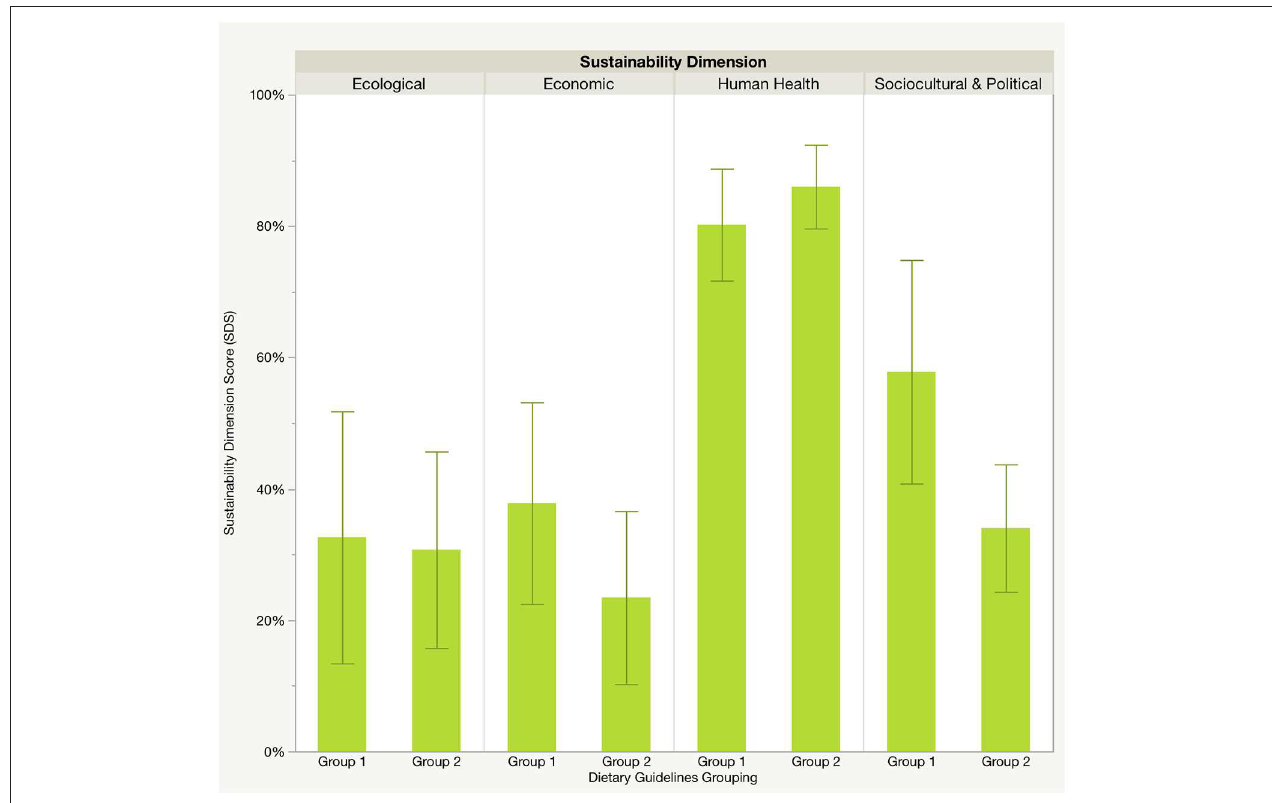
FIGURE 1 | Variation of sustainability dimension scores (SDS) between ecological, economic, human health, and socio-cultural and political sustainability in national dietary guidelines. Application of the sustainability framework tool ( Table 1 ) for presence of sustainability dimensions found sustainability dimension scores (SDS) varied between the four sustainability dimensions with human health being the most represented dimension in the national dietary guidelines examined. Overall, results indicate that the ecological, economic, and socio-cultural and political dimensions of sustainability are underrepresented in national dietary guidelines. Significant differences ( p < 0.0001) were found in means SDS between the four sustainability dimensions. Pair-wise comparison between the four sustainability dimensions demonstrates that the mean SDS of the human health dimension was significantly higher ( p < 0.0001) than that of the economic, ecological, and sociocultural and political dimensions. No significant differences in means of SDS were found between these latter three sustainability dimensions ( p > 0.05). There were no significant differences in the SDS for the dimensions of sustainability between Group 1 countries that are recognized in the literature to integrate sustainability in dietary guidelines compared to Group 2